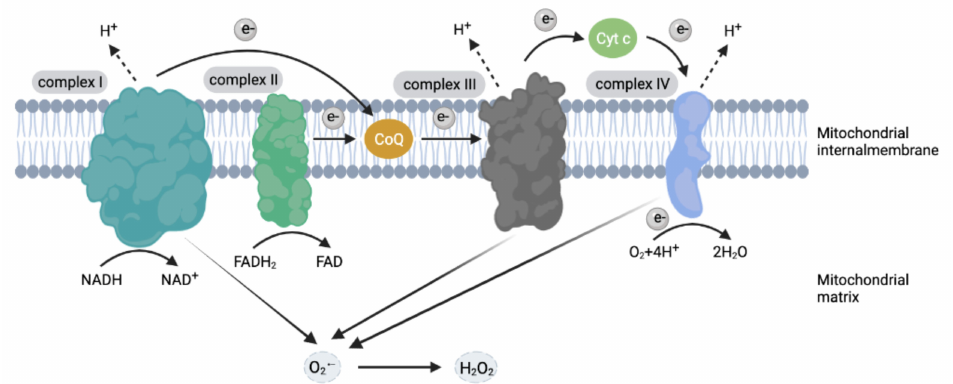
Figure 1. Sources of reactive oxygen species. NADH: nicotinamide adenine dinucleotide; NAD + : nicotinamide adenine dinucleotide; FADH 2 : flavine adenine dinucleotide, reduced; FAD: flavine adenine dinucleotide; Cyt c: cytochrome C; CoQ: coenzyme